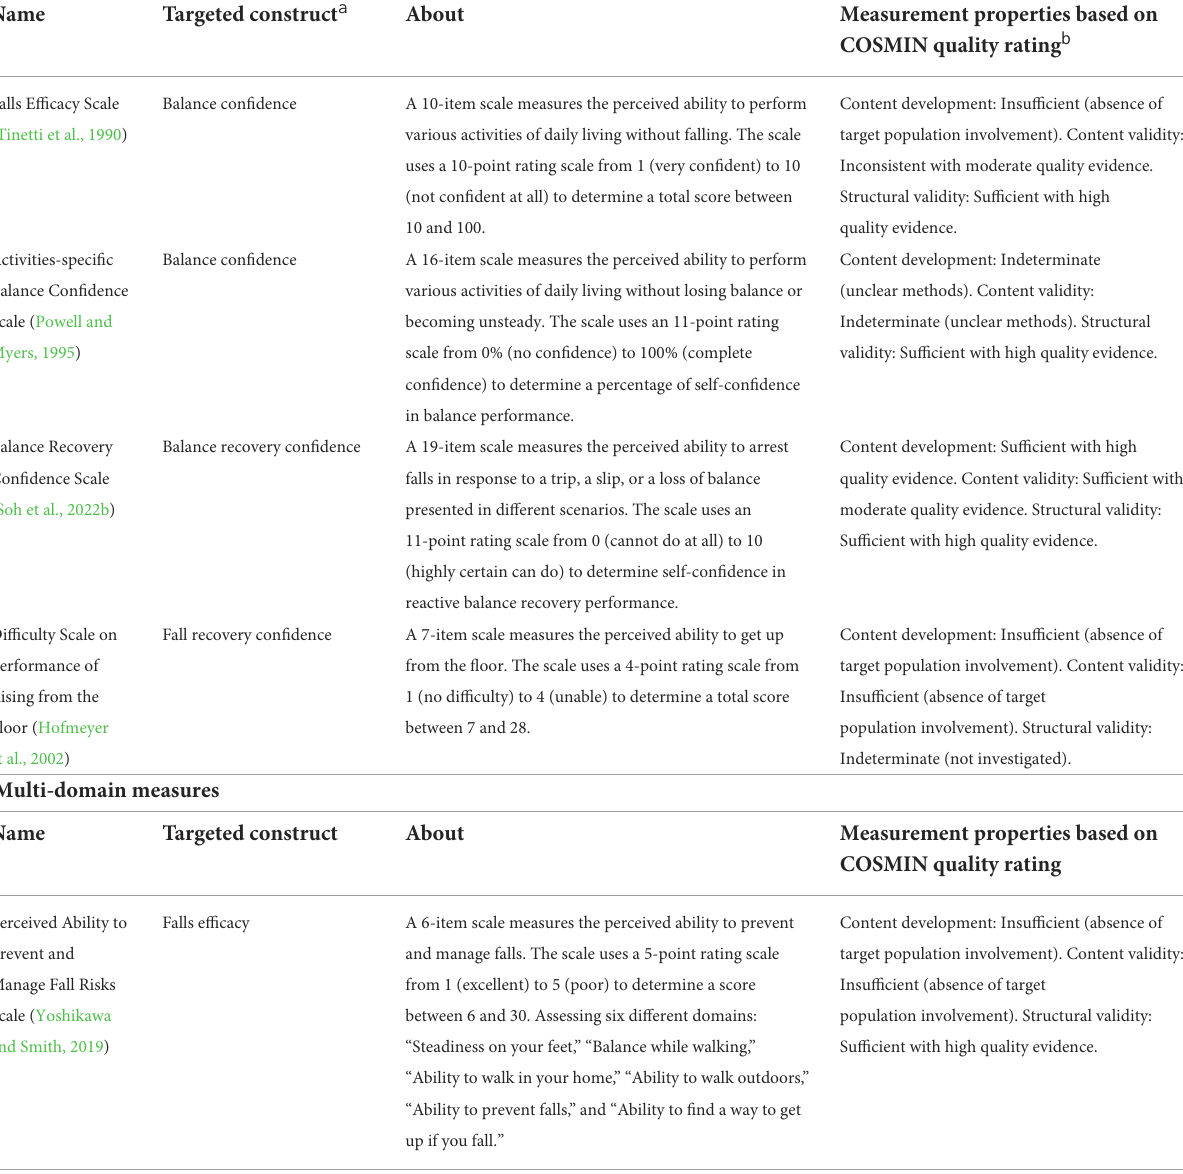
TABLE 1 A list of potential measurement instruments for balance confidence, balance recovery confidence, fall recovery confidence, and falls efficacy based on a systematic review conducted by Soh et al. (2021a). Single domain